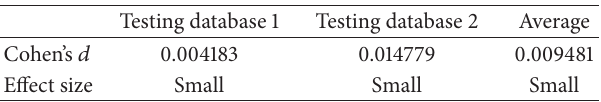
Table 3: The measured Cohen’s 𝑑 between the MAEs by our method and previous one